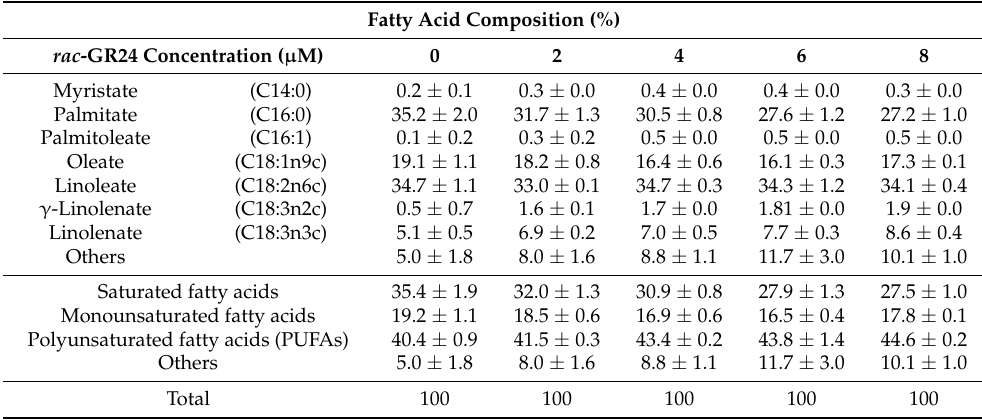
Table 1. Fatty acid composition of Haematococcus pluvialis after 30 d cultivation under different rac -GR24 concentrations (2.0–8.0 µ